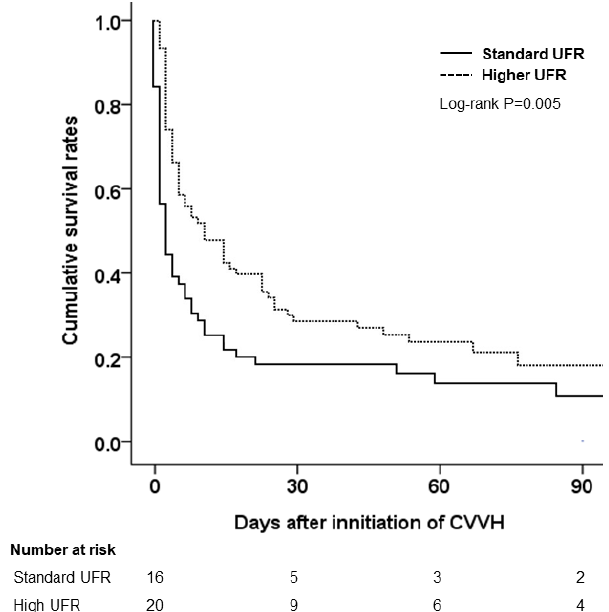
Figure 3. Kaplan–Meier curves of the 90-day mortality that was based on standard and high UFRs a subgroup of patients with SOFA scores of ≥ 15. Abbreviations: UFR, ultrafiltration rate; CVVH, in a subgroup of patients with SOFA scores of ≥15. Abbreviations: UFR, ultrafiltration rate; CVVH, continuous venovenous continuous venovenous hemofiltration.